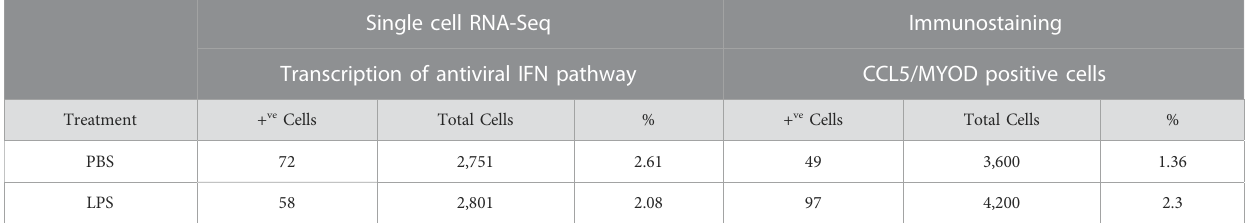
TABLE 2 Distribution of MuSCs with the activated antiviral IFN pathway in PBS- and LPS-treated cells. Representation of the ISC cluster within the control and LPS treated MuSCs was evaluated by co-expression of Isg15 , I fi h1 , Oasl, I fi t1 , and Myod1 as measured by scRNA-Seq. ISC cells were independently assess in culture by co-expression of CCL5 and MYOD by IF.